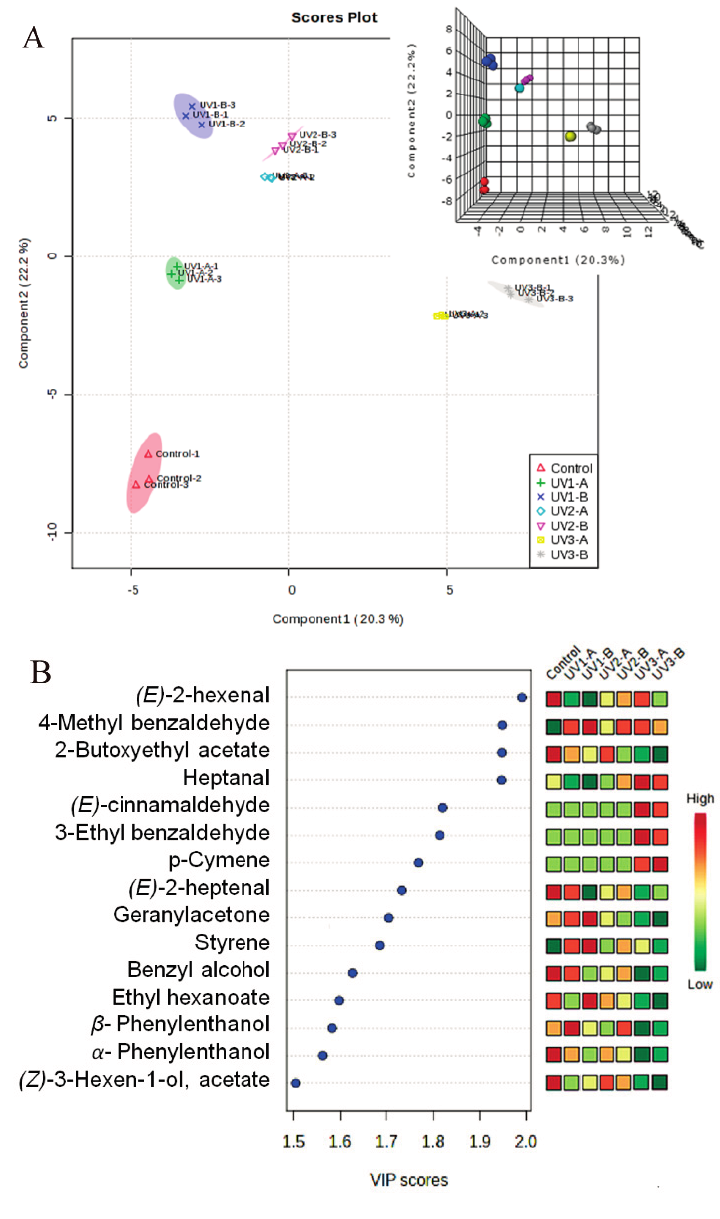
Figure 6. Results of PLS-DA. ( A ) 2D scores plot. The corresponding interactive 3D plot is shown in its top right corner; ( B ) Selected volatile compounds based on VIP